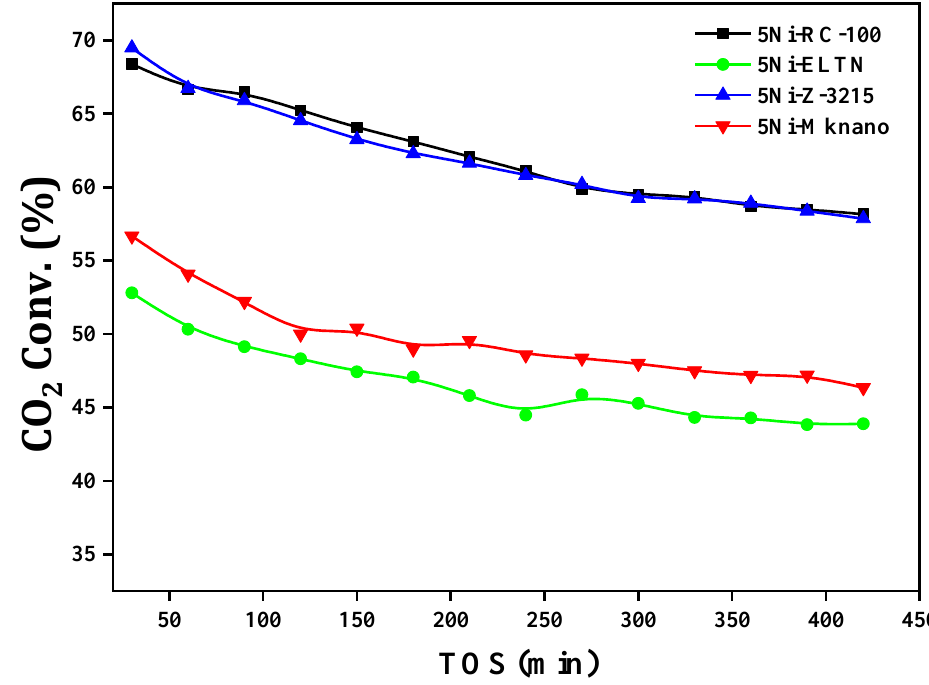
Figure 7. CO 2 conversion for different source zirconia-supported Ni catalysts.